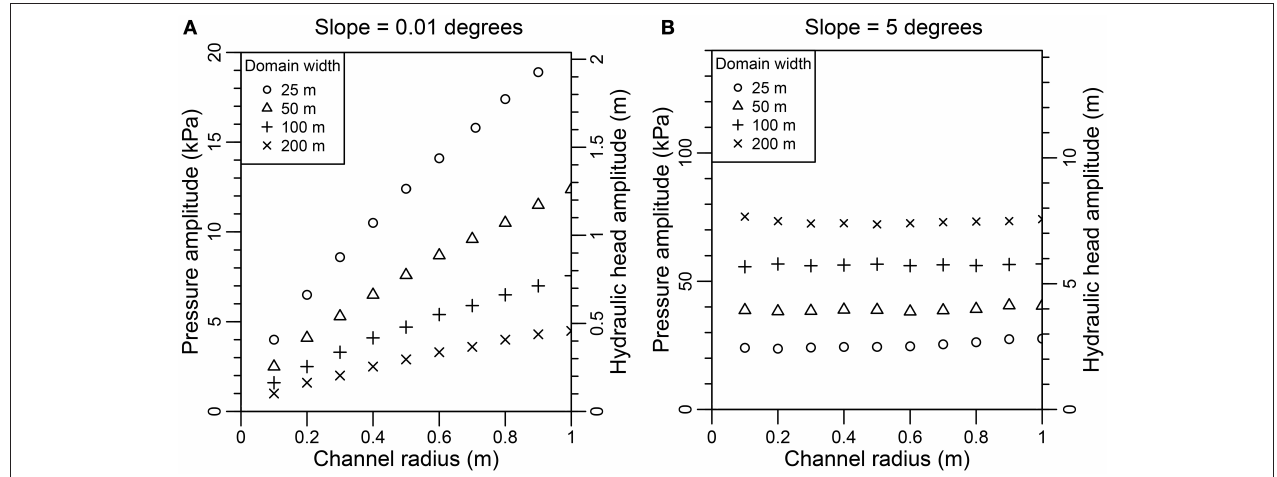
FIGURE 9 | Maximum amplitude of the anti-correlated pressure variation on the bed as a function of subglacial channel radius and domain width for a bed/surface slope of (A) 0.01 degrees and (B) 5 degrees. The amplitude of the forcing or pressure in the channel is 200 KPa. The amplitude is given as pressure P (left-axis) and as hydraulic head h (right-axis) that is calculated using P = ρ water gh and assuming that the pressure at the bed is equal to the water